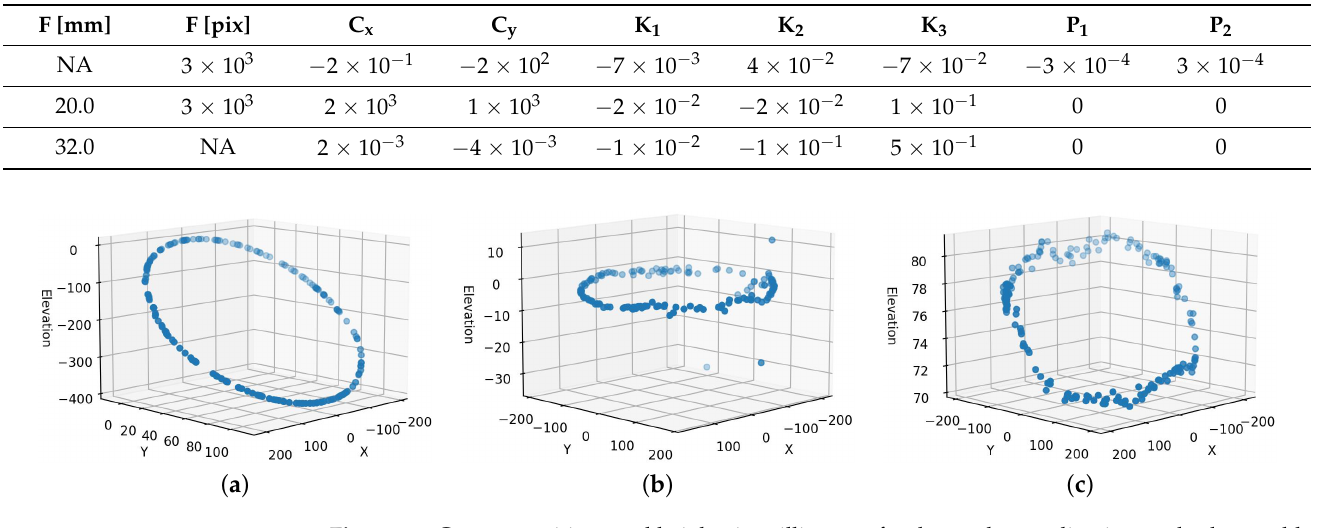
Figure 11. Camera positions and heights in millimeters for the truck recording in standard turntable environment using Agisoft (AG), Pix4d (PX), and RealityCapture (RC). ( a ) AG camera 3D positions. ( b ) PX camera 3D positions. ( c ) RC camera 3D